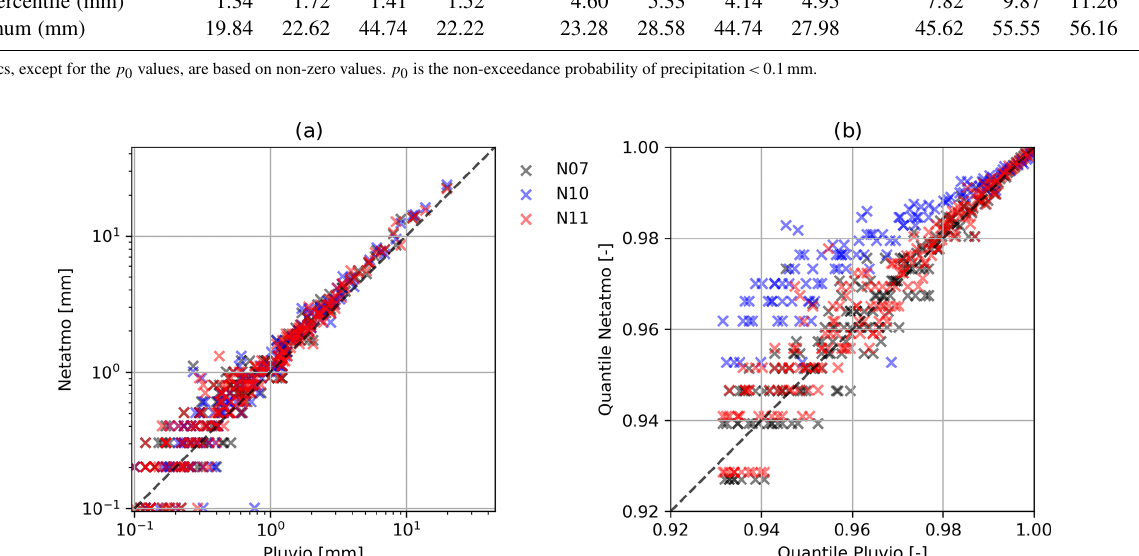
values corresponding to the event for the secondary observa- tion location would be 2.5